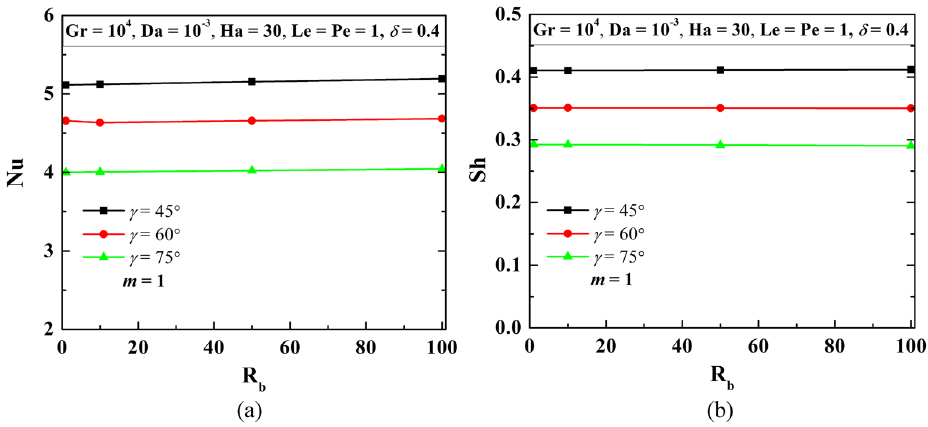
Figure 14. Patterns of average Nu ( a ), and Sh ( b ) when γ at Le = 1, Pe = 1, Gr = 10 4 , Da = 10 –3 , Ha = 30, m = 1, δ = 0.4, for W-shaped cavity.